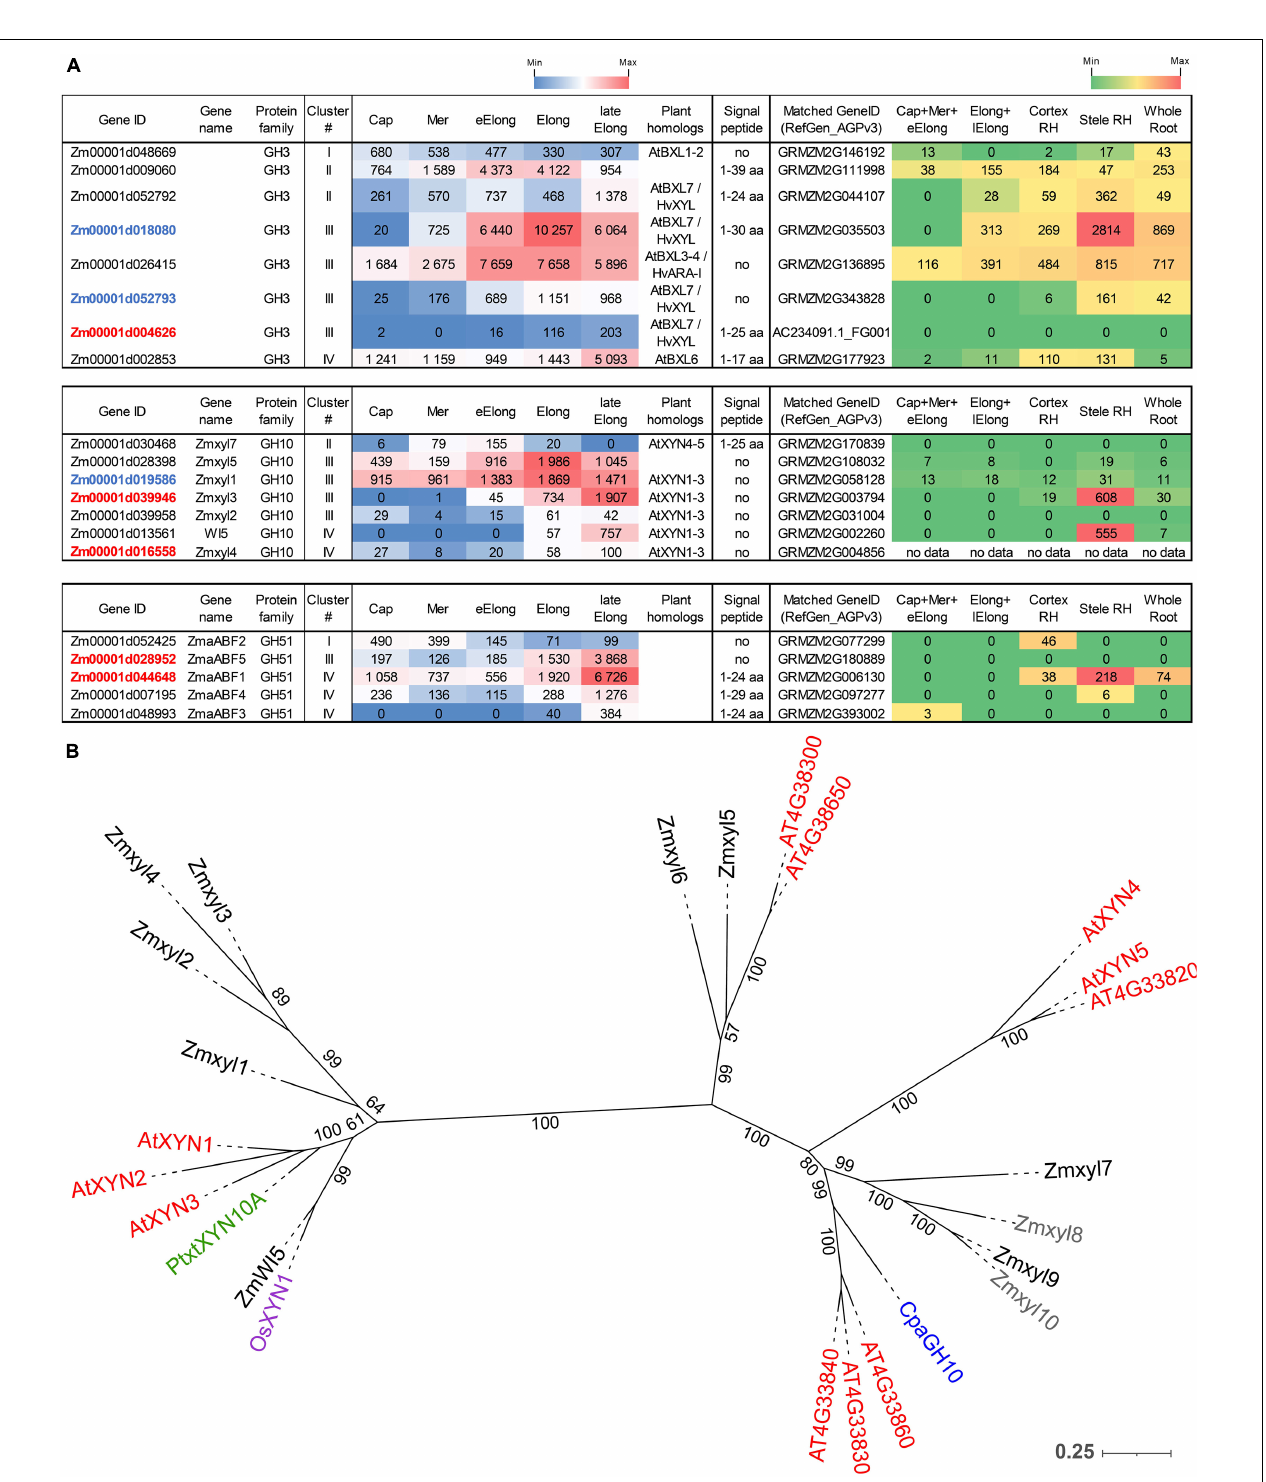
FIGURE 5 | Expression of maize genes encoding putative β - D -xylosidases, xylanases, and α - L -arabinofuranosidases of the GH3, GH10, and GH51 families in maize roots and phylogenetic analysis of plant GH10 family. (A) The level of transcripts (TGR, red-blue heat map) and abundance of corresponding proteins (averaged and normalized total spectral counts (Marcon et al., 2015), red-green heat map) of genes encoding putative β - D -xylosidases, xylanases, and α - L -arabinofuranosidases in various zones of maize roots. Genes with expression values below 100 in all the studied samples are not shown. TGR values are sorted from maximum to minimum within each cluster. Maize genes co-expressed with primary and secondary cell wall cellulose-synthases are given in blue and red, respectively. Maize gene names